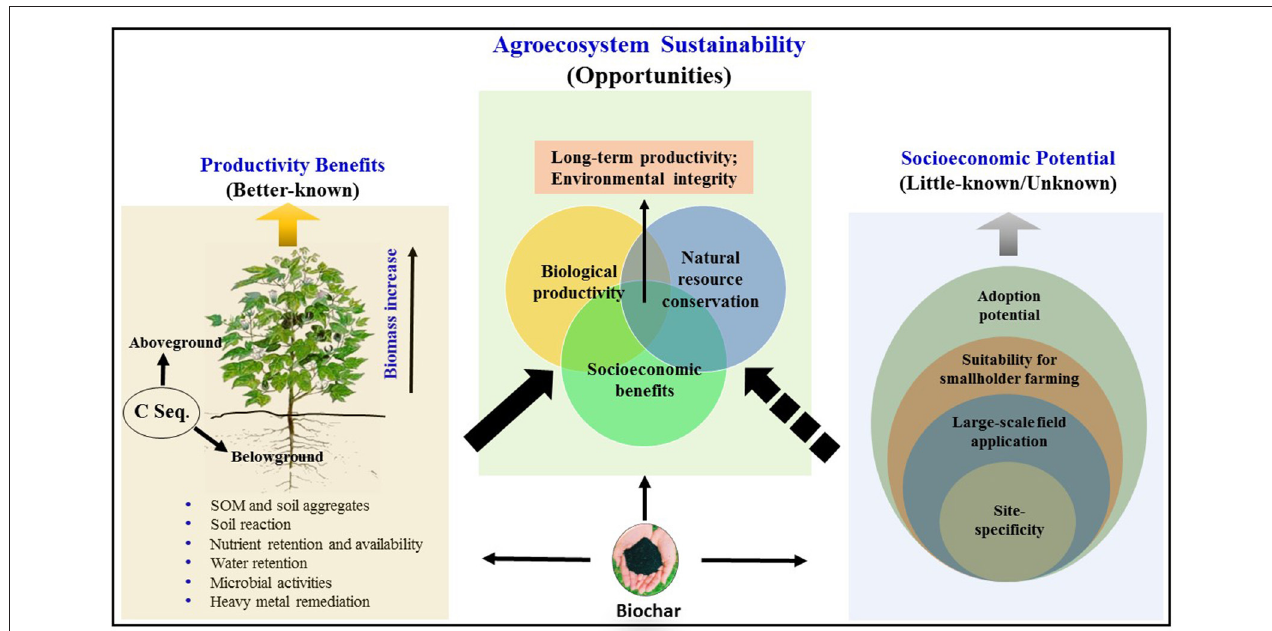
FIGURE 1 | A schematic presentation of the role and potential of biochar in the agroecosystem–climate-change–sustainability nexus. Integration of relatively better-known productivity benefits with the yet-to-be-found solutions to little-known and unknown factors is conceptualized. C = carbon; C seq. = carbon sequestration; SOM = soil organic